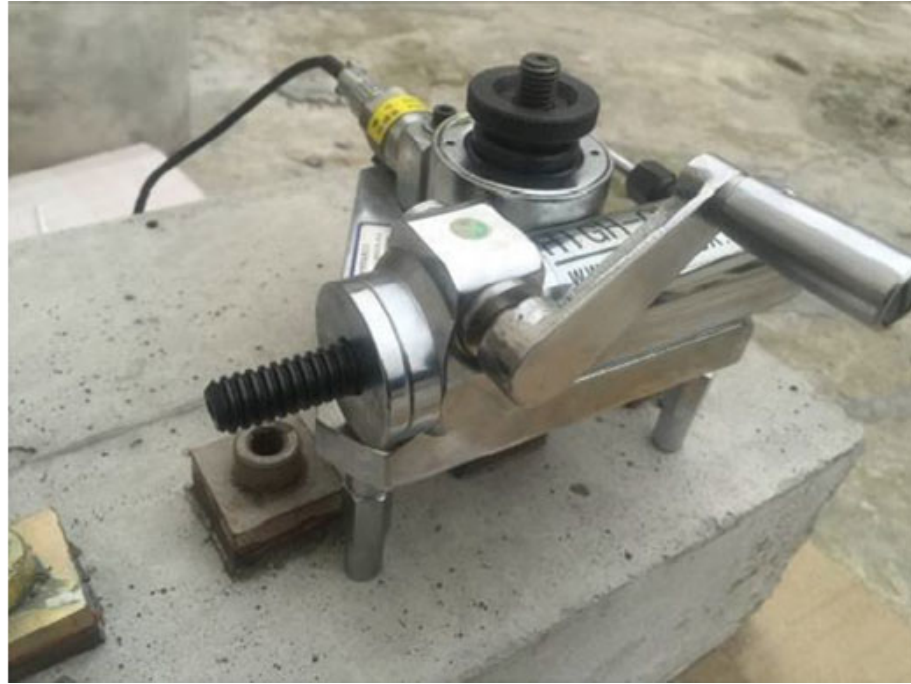
Figure 5. Tests for pull ‐ put bond strength between repair materials and concrete substrate [59]. (Adapted and reprinted with permission from ref. 59, © 2018, Construction and Building Materials .).